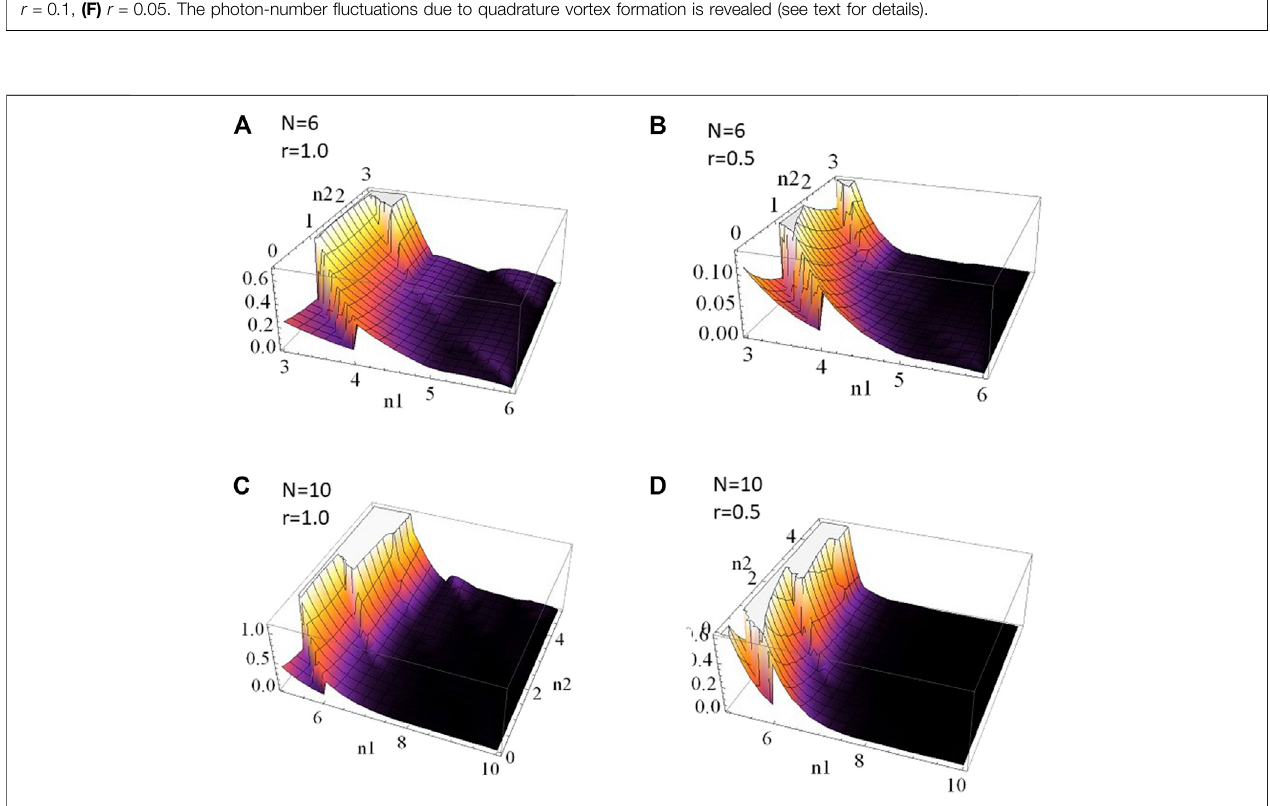
FIGURE 5 | Numerical simulations of photon-number statistics P ( n 1 , n 2 ) for quadrature vortex states, taking n 1 ≥ n 2 , and a truncation parameter given by N total photons inthetwo-modestate,forarotationparameter ϕ (cid:3) π / 4.NumericalresultsaredisplayedinPanel5for: (A) N (cid:3) 6and r (cid:3) 1, (B) N (cid:3) 6and r (cid:3) 0 . 5, (C) N (cid:3) 10and r (cid:3) 1, (D) N (cid:3) 10 and r (cid:3) 0 . 5. The photon-number distribution peaks at n 1 (cid:3) n 2 ≈ N / 2.